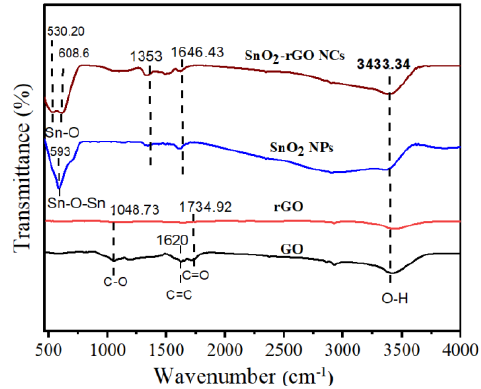
Figure 6. Raman spectra of the SnO 2 NPs and SnO 2 -rGO NCs ( A ); magnified Raman spectra of the SnO 2 NPs and SnO 2 -rGO NCs ( B ).